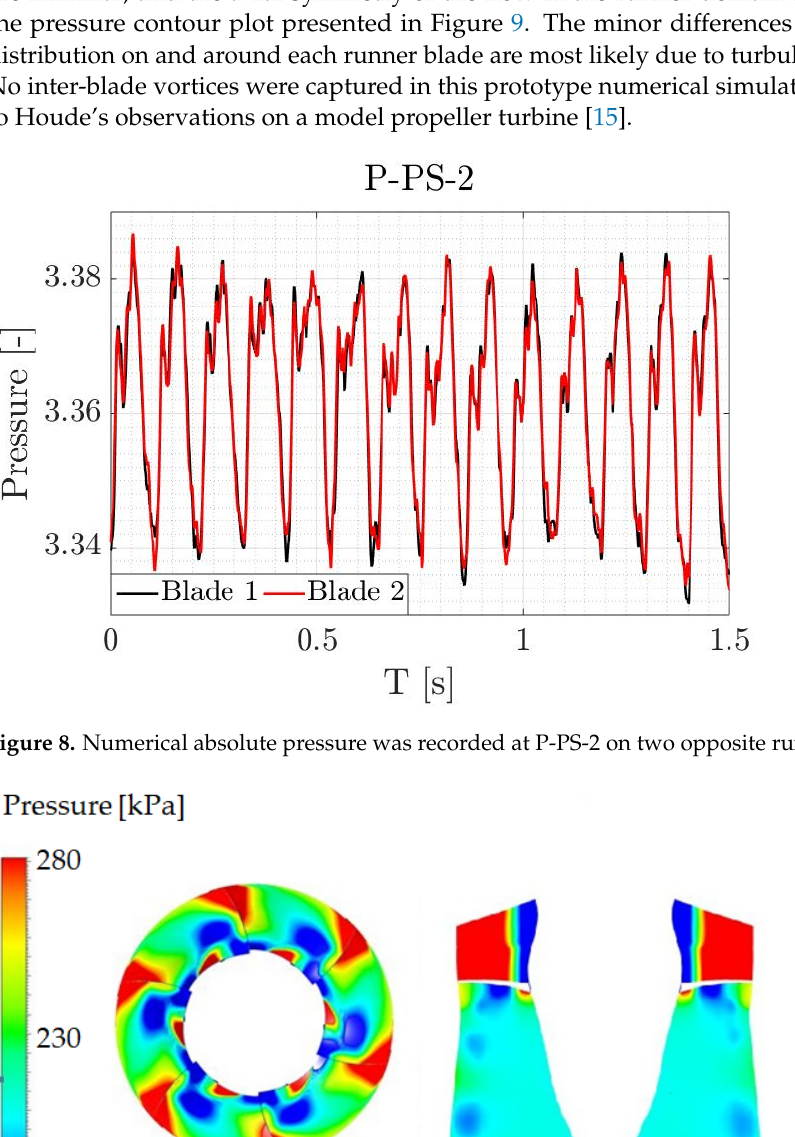
9 of 19 Table 4. Scaled mean absolute pressure values. Sensor Location 37.2 Figure 7. Scaled mean absolute pressure values.